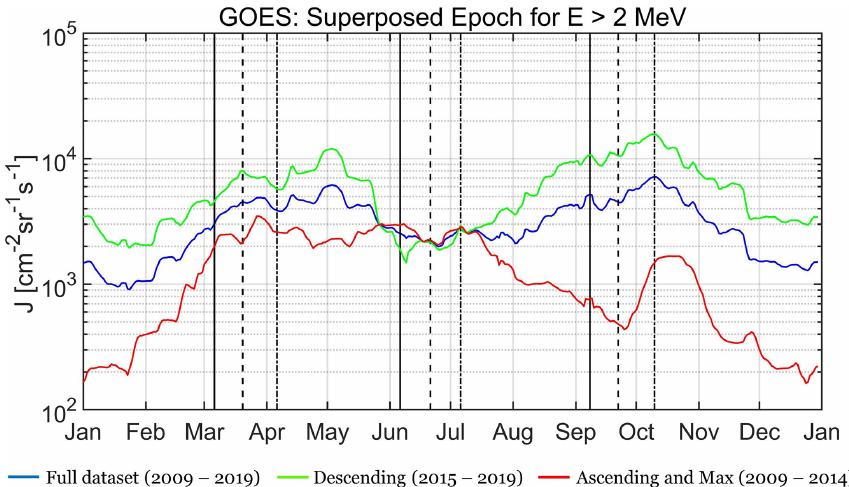
Figure 3. Annual superposed epoch analysis showing 28d moving average electron fluxes at E > 2MeV from GOES/EPS during three time periods: the whole SC24 (solid blue line), the ascending phase and maximum (solid red line) and the descending phase (solid green line). Similar to Fig. 1, the vertical lines correspond to the equinoxes’ maxima and the summer solstice minimum predicted by the three mechanisms (Cliver et al.,